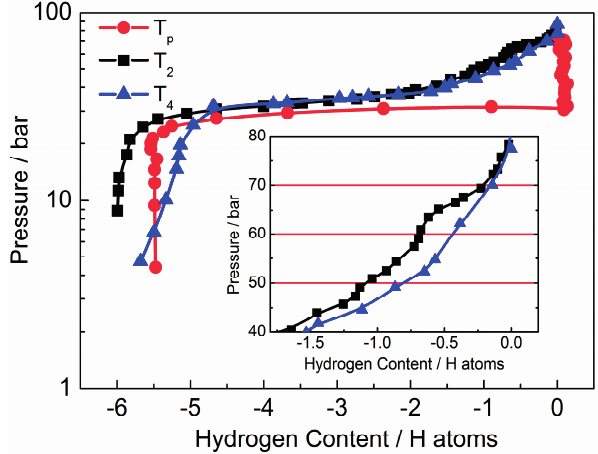
Figure 5. Dehydrogenation Pressure–Composition–Isotherm (PCI) curves of 2Mg(NH 2 ) 2 –3LiH (T p ), 2Mg(NH 2 ) 2 –3LiH–LiBH 4 (T 2 ) and 2Mg(NH 2 ) 2 –3LiH–1/3LiBH